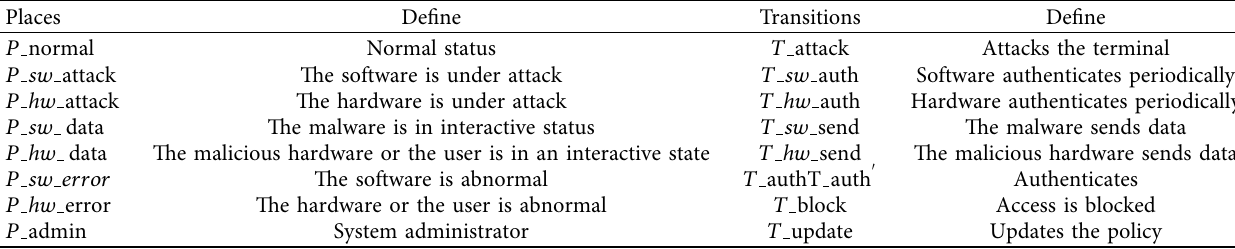
Figure 6: ZTM SPN model. Table 3: Te set of places and transitions in the ZTM SPN model.